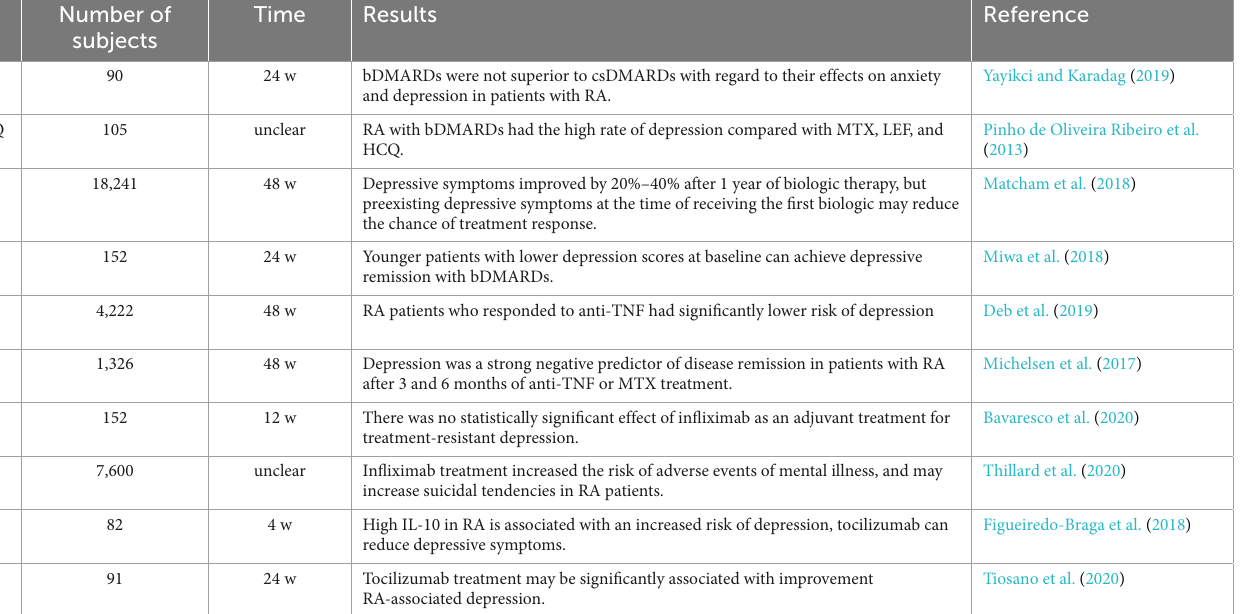
TABLE 1 Biotherapies for RA-associated